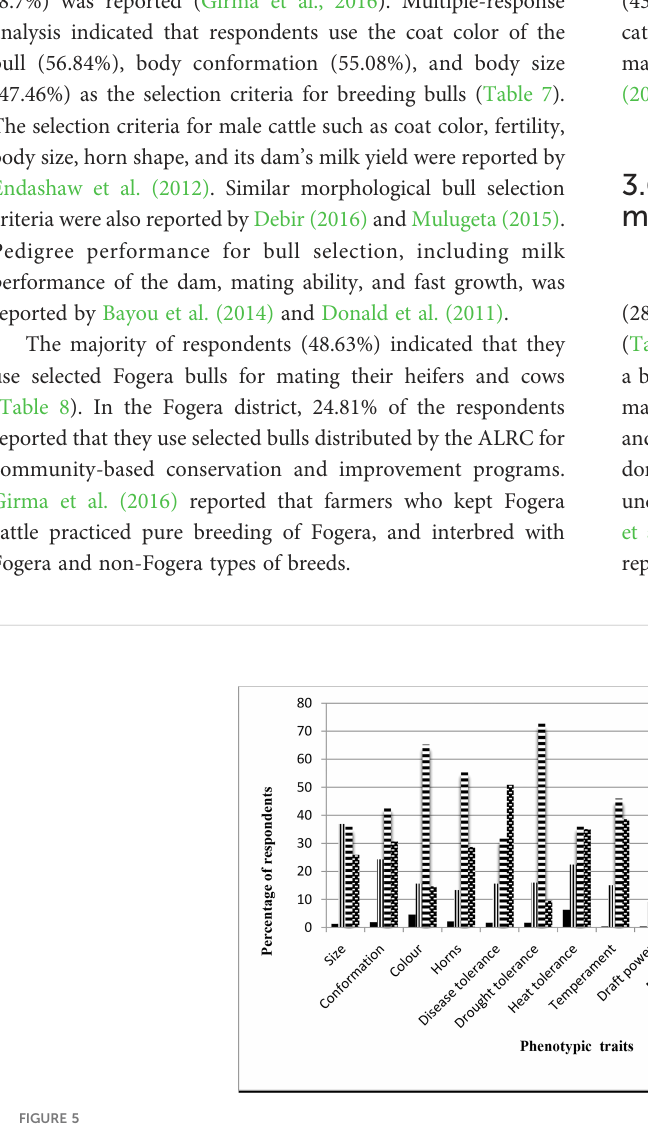
N, number of respondents; %, percentage of